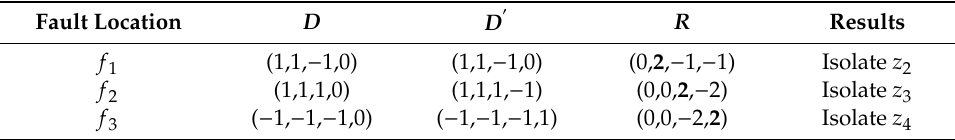
Table 5. Pole-to-pole fault simulation results for centralized pilot protection.